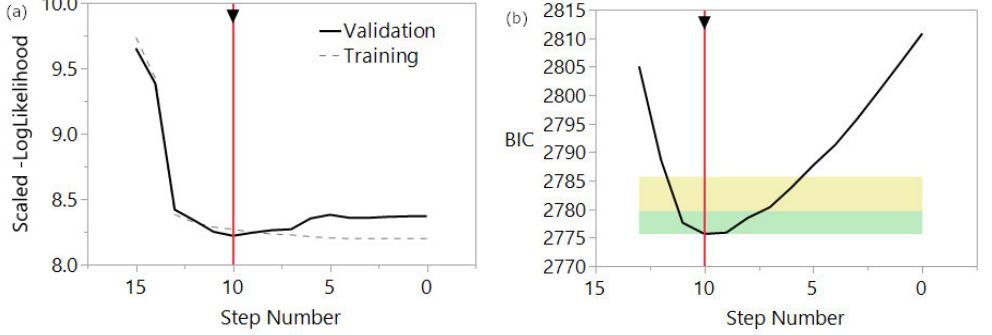
Figure 4. Comparison of the model performances as a function of the step in the algorithm, i.e., the number of factors that were removed from the model. Note that progression on the abscissa is from right to left. The vertical red line indicates the optimal model according to the algorithm. ( a ) -LogLikelihood for the training and validation sets. ( b ) BIC for the full data set; the green area indicates “very good” model performance (strong evidence that a model is comparable to the best model); the yellow area indicates “good” model performance (weak evidence that a model is comparable to the best model)